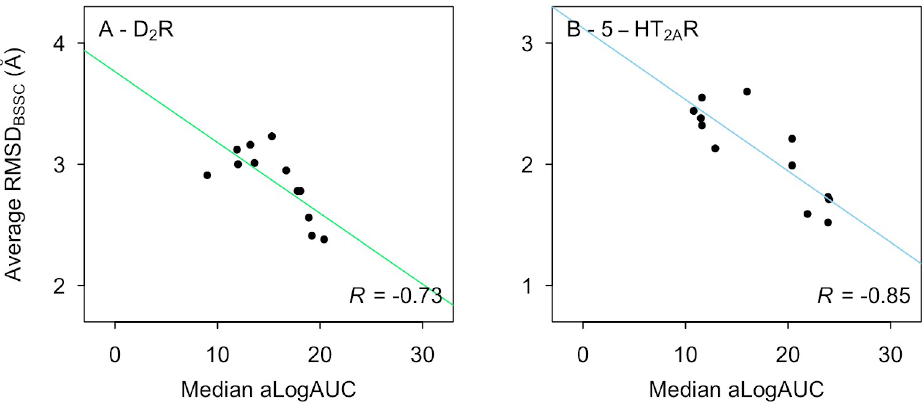
Fig 5. Relation between ligand enrichment and structural accuracy. The median aLogAUC and average RMSD BSSC to the crystal structures for 50 homology models of the D 2 R (A) and 5-HT 2A R (B) based on aminergic templates. The solid line represents a linear regression and R is Pearson’s correlation